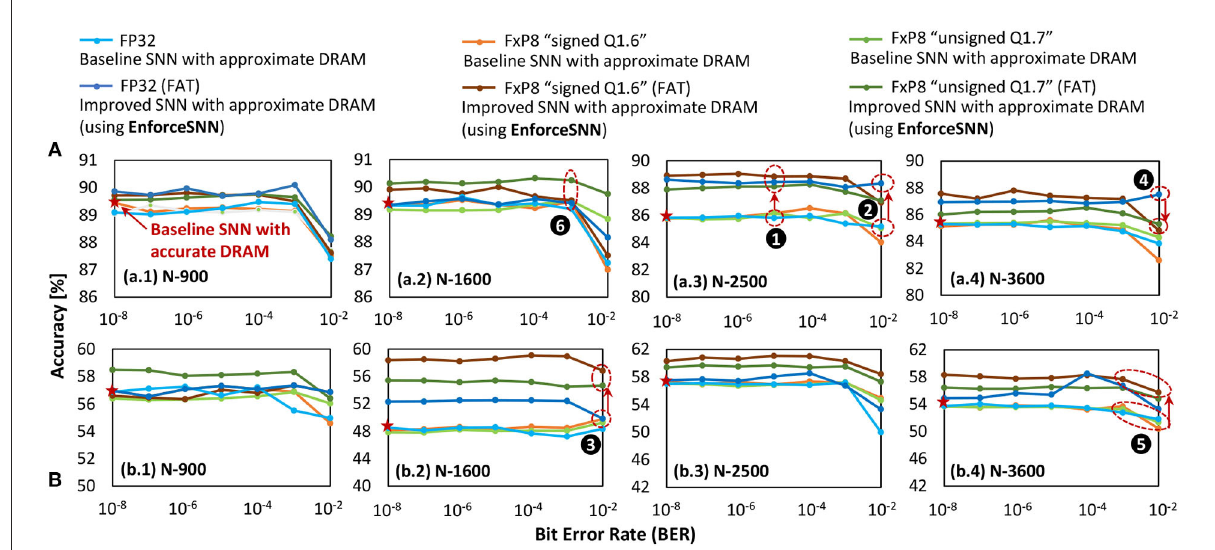
FIGURE11 The accuracy of the baseline model with accurate and approximate DRAM, as well as the EnforceSNN-improved model with approximate DRAM for (A) MNIST and (B) Fashion MNIST datasets, across different precision levels, different BER values, and different network sizes.